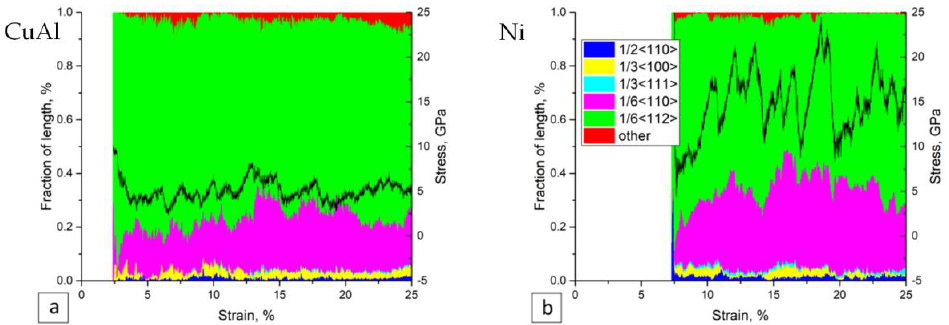
Figure 10. The fraction of the length of each type of dislocation (P) depending on the strain: ( a ) CuAl alloy and ( b ) nickel. The black line is the stress – strain curve.